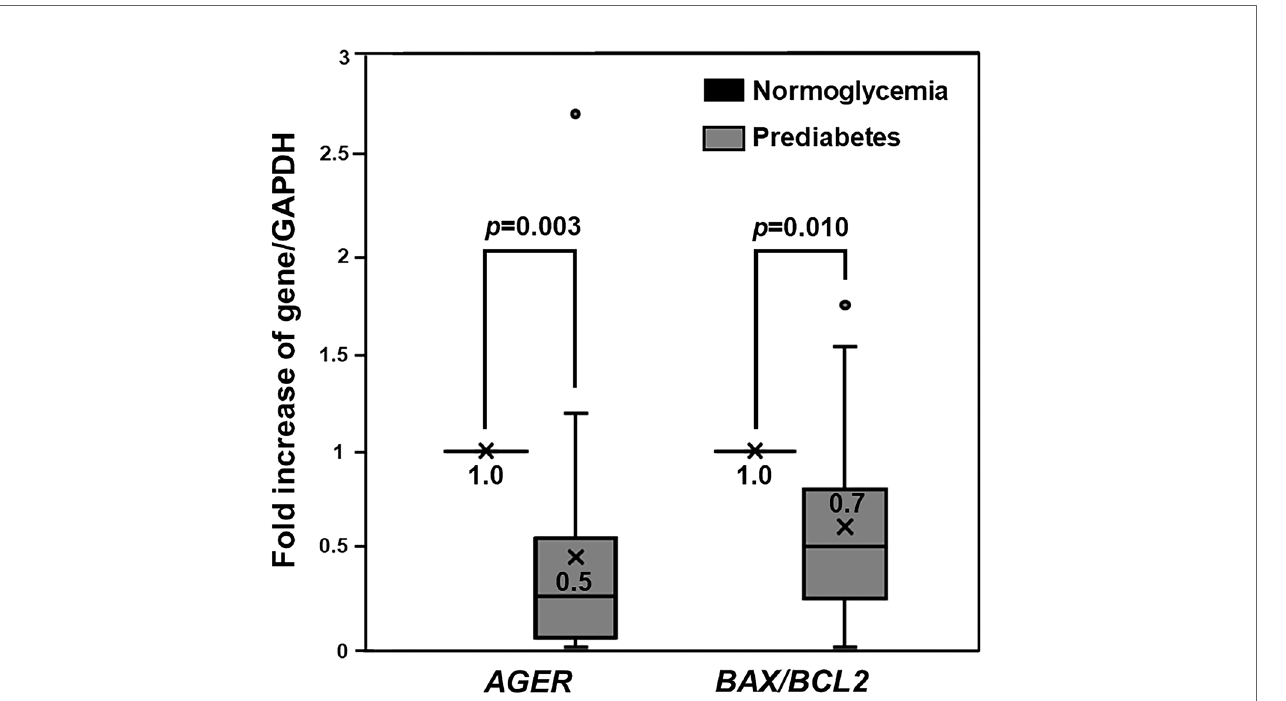
FIGURE 2 | The Expression of AGER , BAX , and BCL2 Genes. Box and whisker plots to show a comparison of AGER and BAX/BCL2 ratio between PBMC-isolated from individuals with normoglycemia and prediabetes. AGER and BAX/BCL2 ratio in PBMC-isolated from individuals with prediabetes were signi fi cantly suppressed by 2 and 1.4 folds, respectively, compared to those in age- and pentosidine-matched PBMC-isolated from participants with